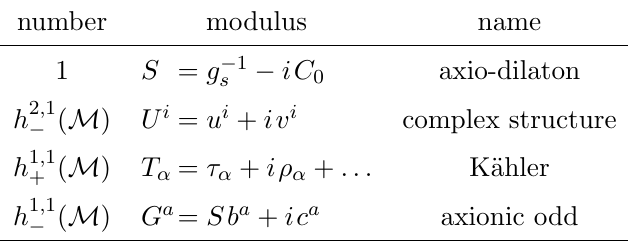
Table 1 . Closed string moduli in type IIB orientifold